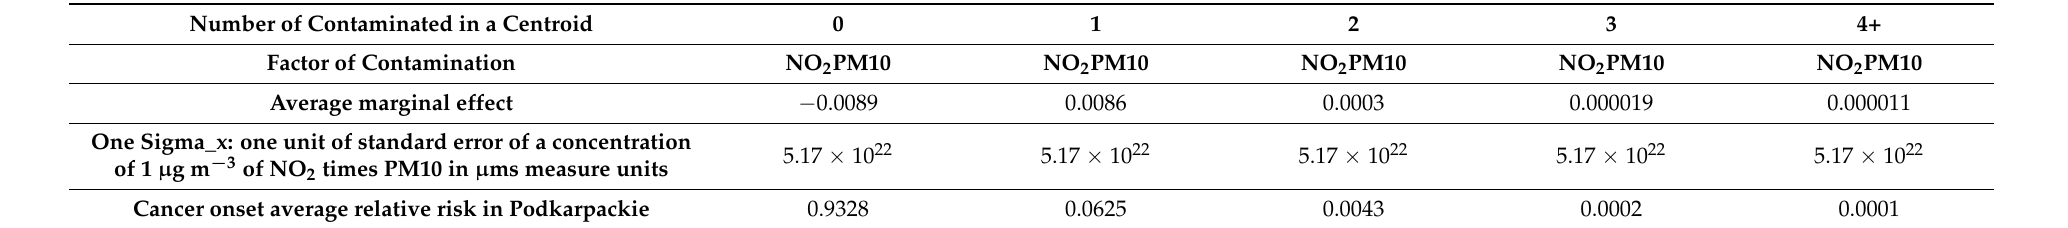
Table 6. Women squamous cancer: factors and risks.